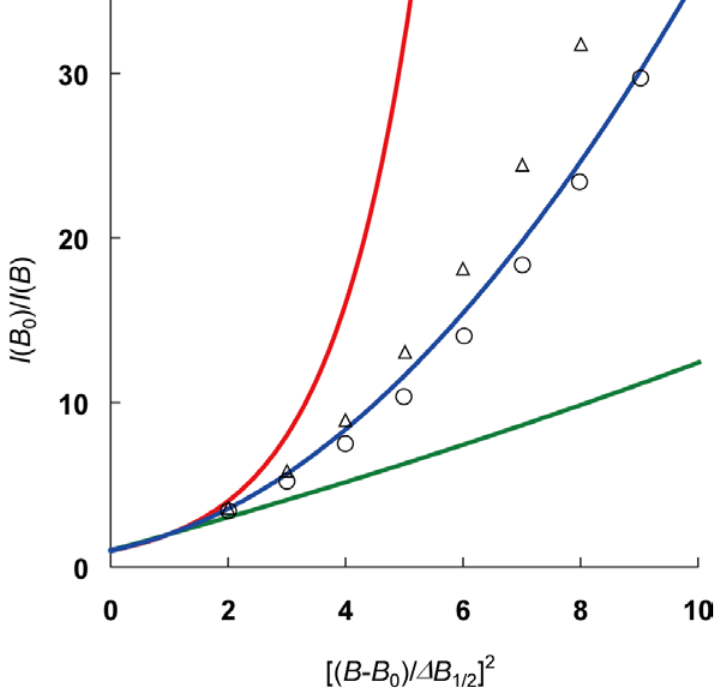
Figure 4. Dietz’s plot [25,36] of the line shape of X-band ESR spectra of compound 1 at 293 K (circles) and 104 K (triangles). Colored curves show the line shape and the inter- spin behavior: a Lorentzian (green, 3-D exchange interaction or motional narrowing), a Gaussian (red, only dipolar interaction), and an intermediate between them (blue, 1-D spin